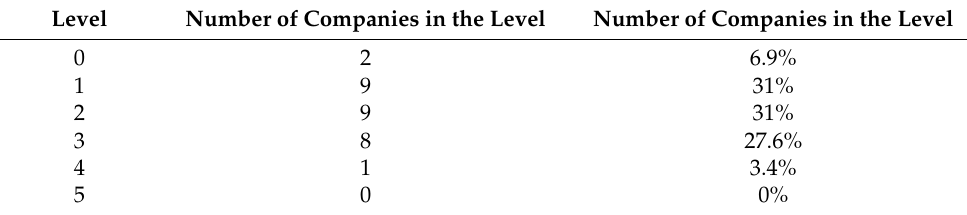
Table 8. Summary data on the number of enterprises and their levels in the current variant. Level Number of Companies in the